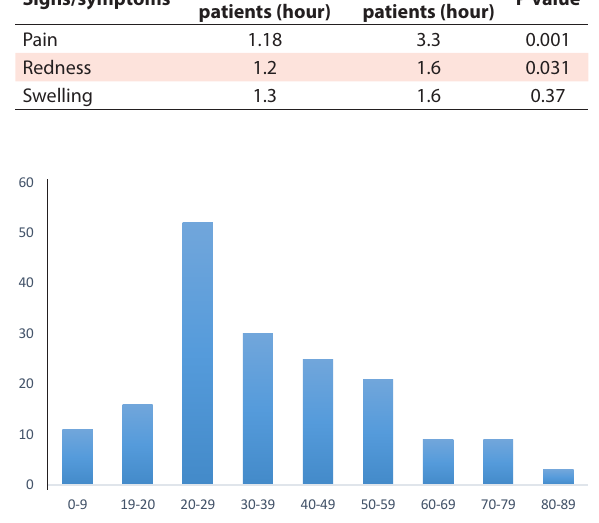
Figure 1. Distribution of patients by age